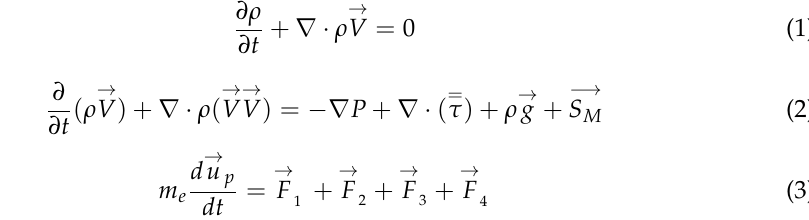
Figure 1. Elbow geometry: ( a ) double offset U-bend; ( b ) 180° U-bend.